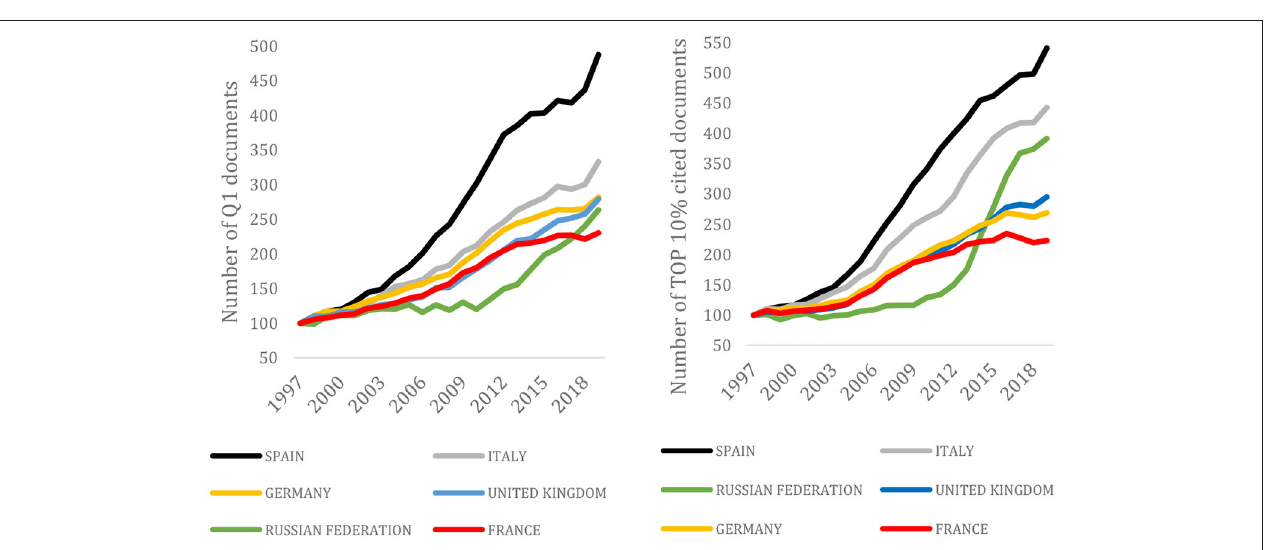
FIGURE 6 | Number of Q1 documents and TOP 10% cited documents of the selected European countries. 1997–2020. 1997 = 100. InCites.